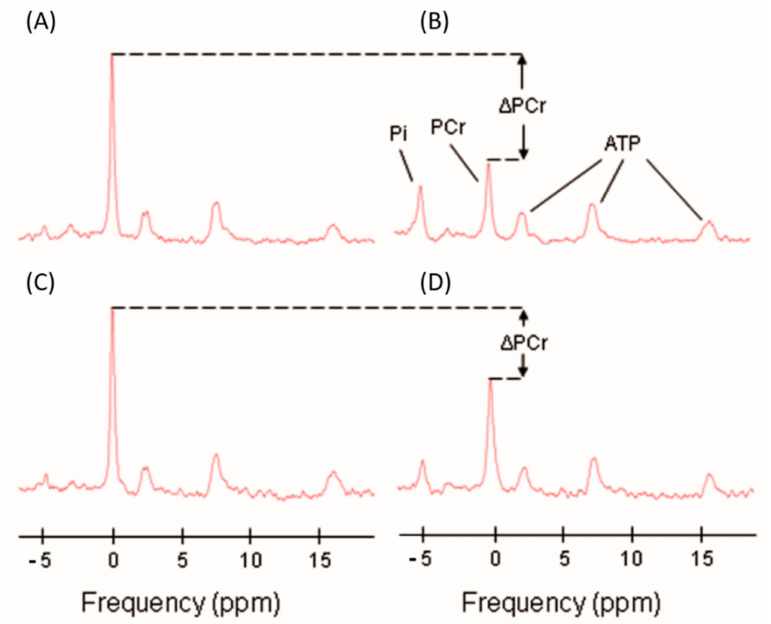
Figure 3. Representative 31 P spectra with inorganic phosphate (Pi), phosphocreatine (PCr), and ATP resonances indicated in panel ( B ). Panels ( A , B ) show examples of baseline and postexercise spectra of a typical level of exercise induced PCr depletion ( ∆ PCr). Panels ( C , D ) represent examples of baseline and postexercise spectra with a minimally acceptable level of PCr depletion ( ∆ PCr = 33%)